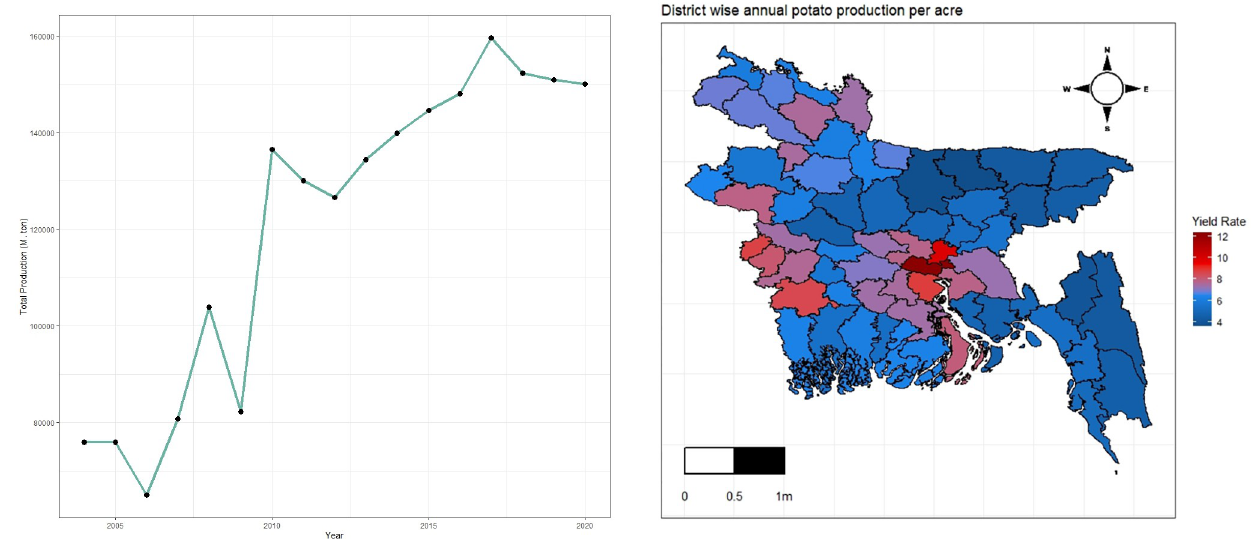
Fig 1. Potato production in Bangladesh, (a) time series plot, (b) spatial distribution.